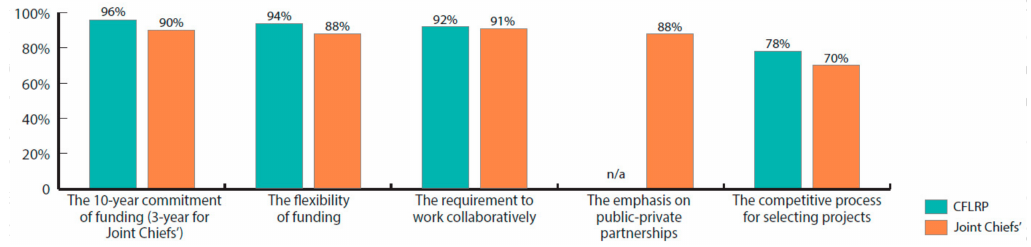
Figure 4. Percent of respondents who rated program aspects as somewhat or very valuable. Note: The items in the figures were the ones selected by the most participants and do not include all items included in the respective sections of the